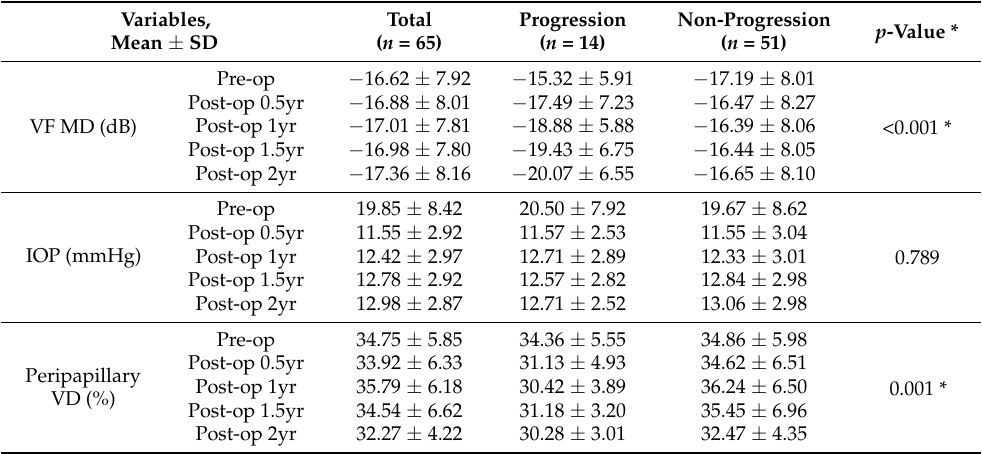
Table 3. Comparison of the postoperative changes of VF MD, IOP and peripapillary VD between the VF progression and non-progression